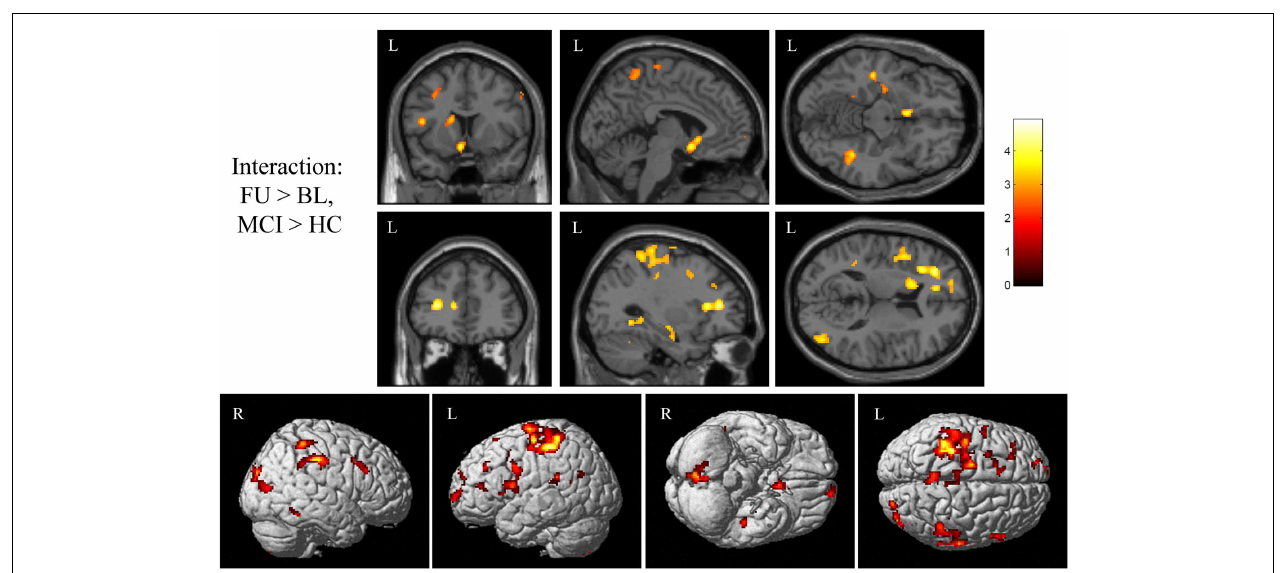
maxima that reach a voxel-wise threshold of p < 0.001 (uncorrected; see TableA3 in Appendix). Further, numerous clusters reach a cluster-wise significance of p < 0.05 (family-wise error correction for multiple comparisons), including clusters in the left frontal lobe, basal nucleus/caudate, left parahippocampal gyrus, bilateral postcentral gyrus, left precentral gyrus, right parietal lobe, anterior cingulate, left insula, left temporal lobe, and cerebellum. See the Section “Results” and TableA3 in Appendix for additional results. MCI = mild cognitive impairment, HC = healthy older adults, R = right, L =